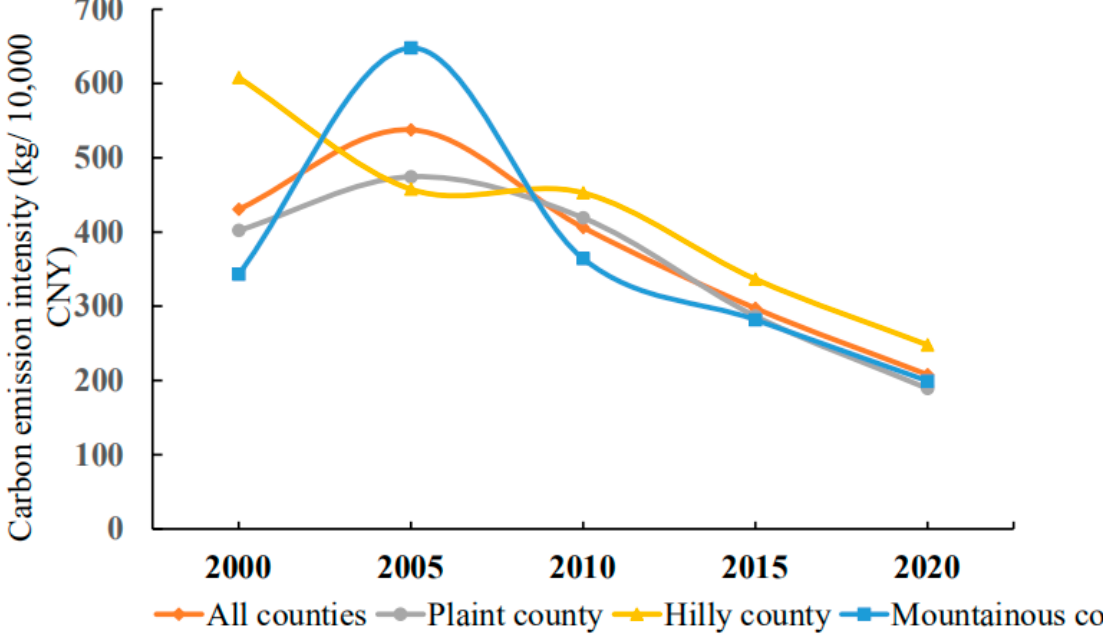
Figure 8. Topographic differences in carbon emission intensity in Hubei Province.